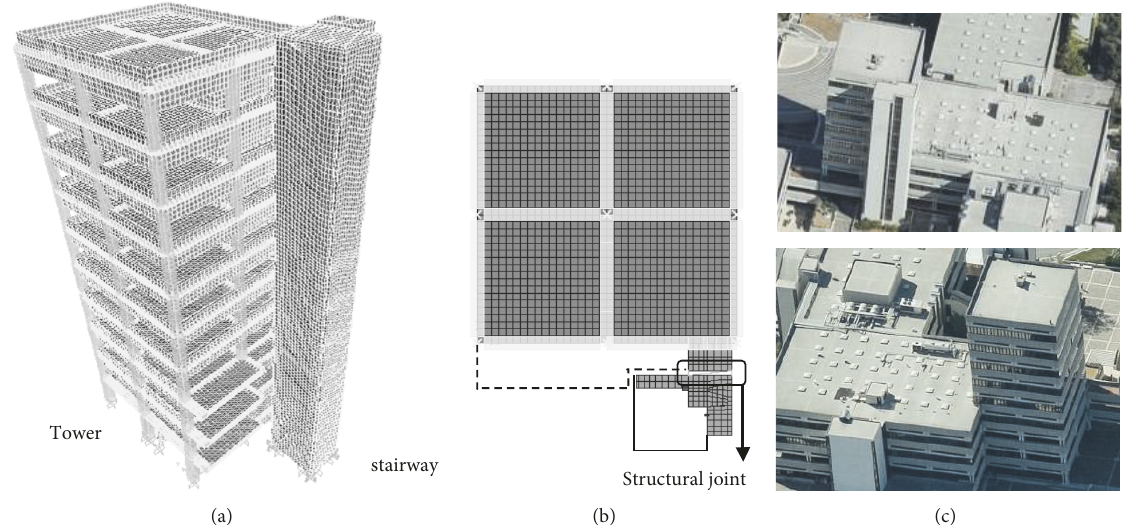
Figure 5: (a) 3D finite element model of the Tower; (b) plan view of the floor slab; (c) Tower interactions with adjacent buildings.